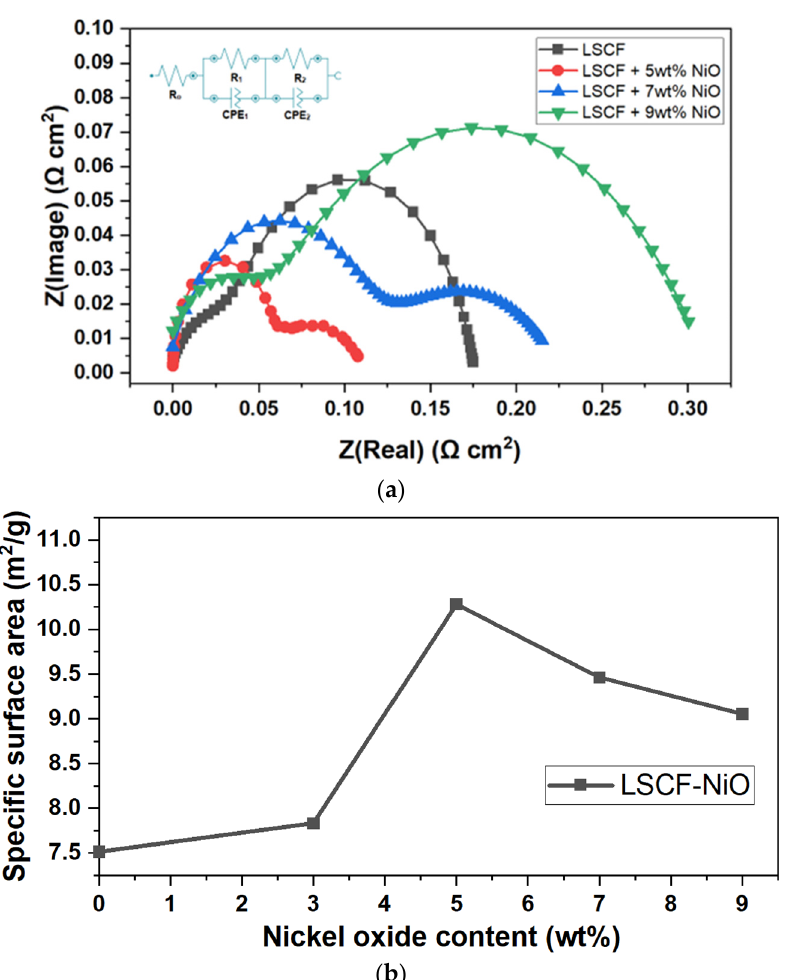
Figure 2. ( a ) Polarization resistance of bare LSCF and LSCF-NiO with various NiO loading content at operating temperature 800 °C. ( b ) Specific surface area of various nickel oxide loading towards LSCF powder.